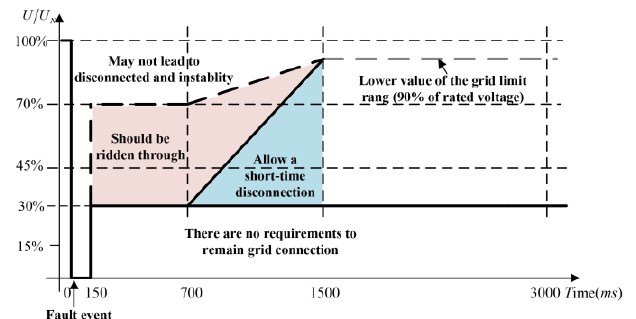
Figure 4. LVRT (low voltage ride-through) curves in German grid code.